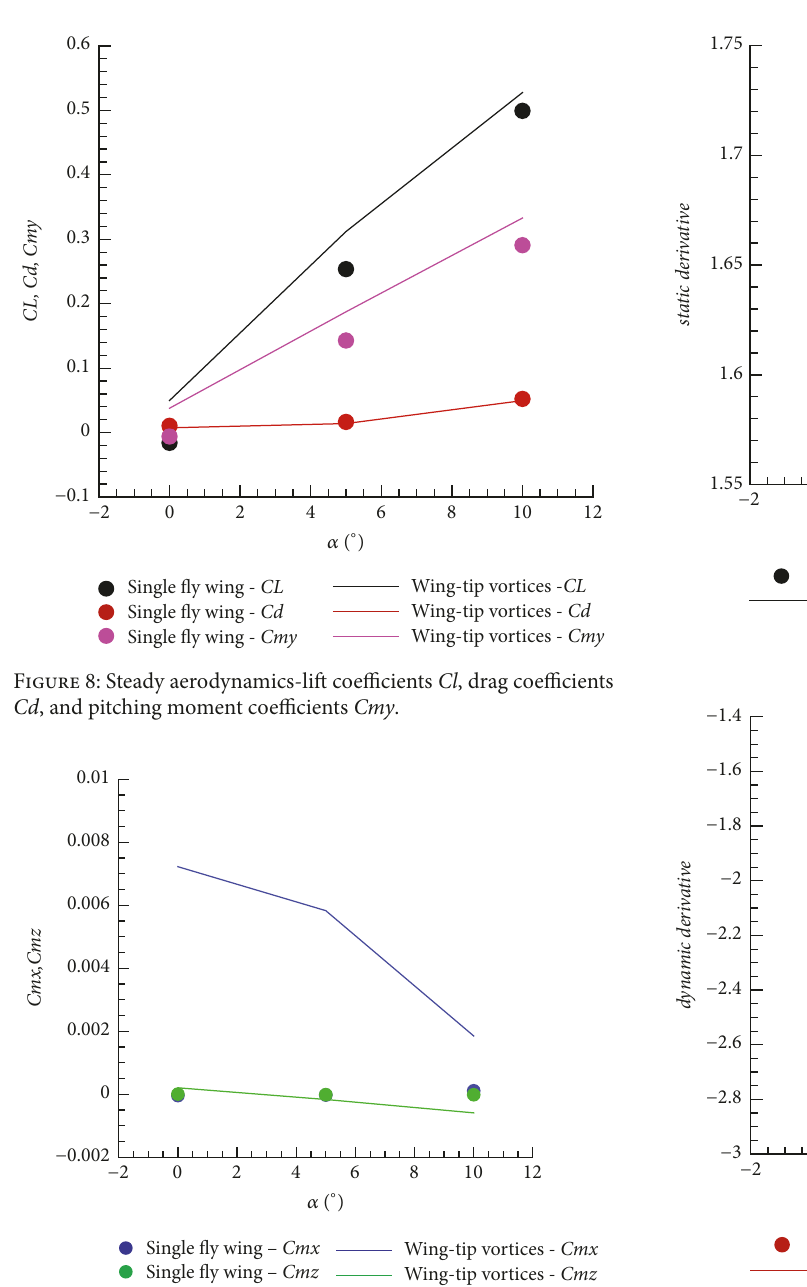
Figure 9: Steady aerodynamics, rolling moment coefficients Cmx and yawing moment coefficients Cmz.